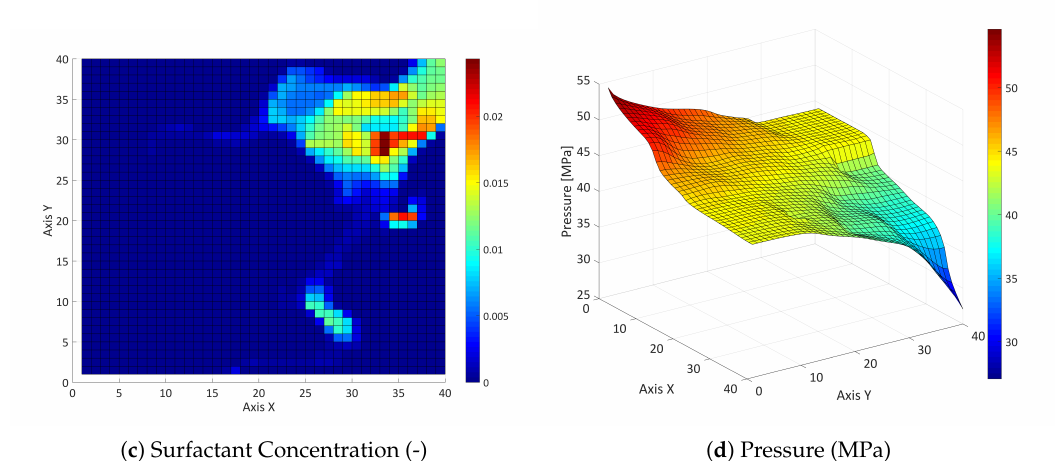
Figure 16. Surfactant concentration after 500 days ( a ), 1000 days ( b ), and 2000 days ( c ), and pressure profile ( d ) at the end of an EOR flooding with k c = 0.50 in a random permeability reservoir.